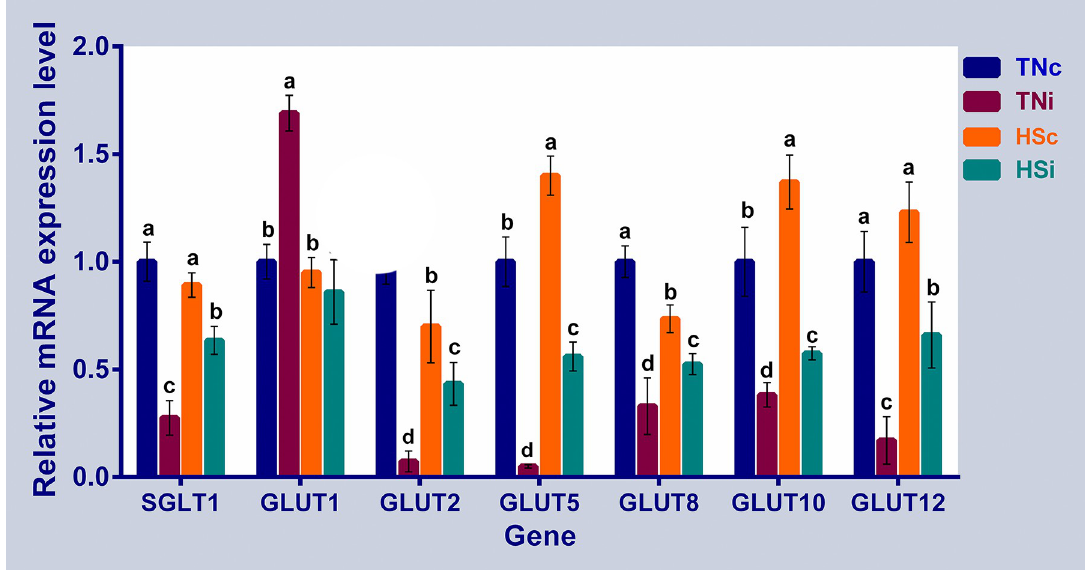
Fig 4. The mRNA expression of the ileal hexose transporters. The mRNA fold expression of the ileal hexose transporters at 6 dpi of chickens infected with E . maxima and their uninfected controls that are raised in a thermoneutral or heat stress environment: TNc = thermoneutral control, TNi = thermoneutral infected, HSc = heat stress control, HSi = heat stress infected. Significant differences (p < 0.05) were depicted by different letters. The error bars represent the